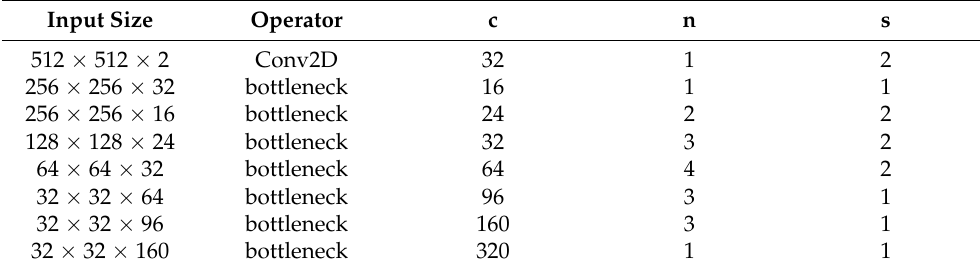
Table 1. The structure of MobileNetV2 used in this